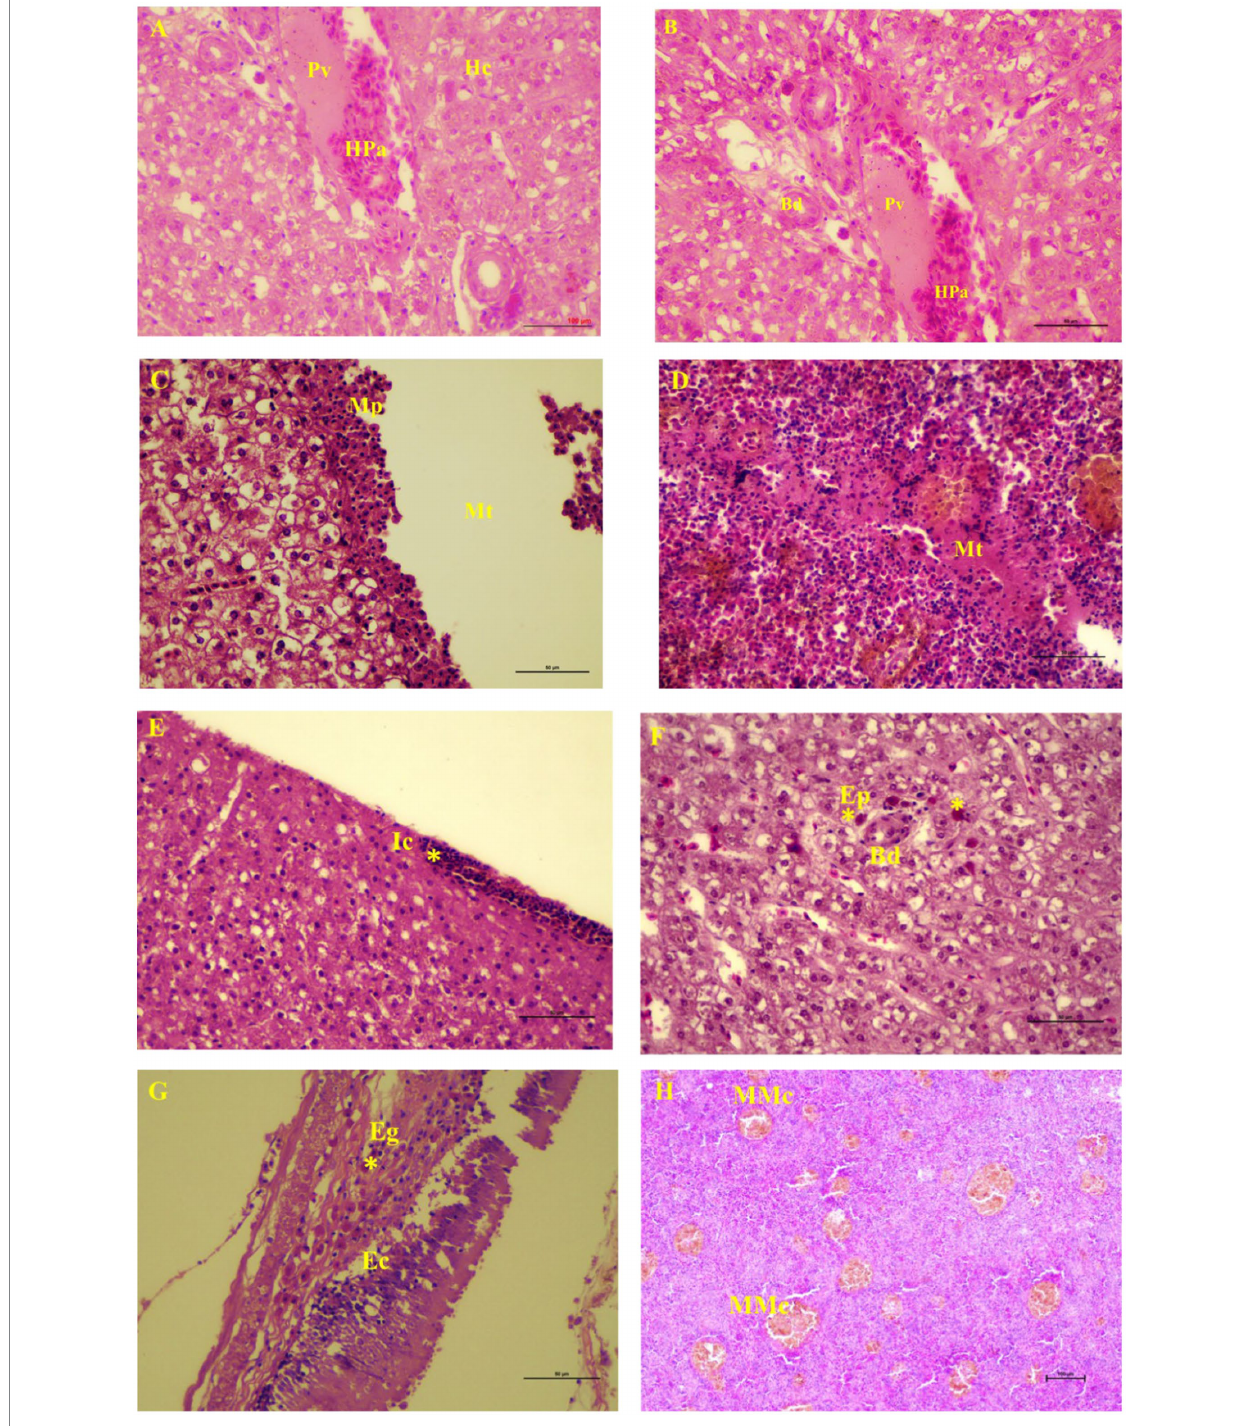
FIGURE 1 Light micrographs of visceral organs of Trichopodus pectoralis non-infected (A) and infected (D–H) with Clinostomum piscidium (H&E stained). (A) Liver of non-infected fish shows the normal arrangement of hepatocytes (Hc) into cords or plates. Hepatopancreas (Pa) lies around a portal vein (Pv). (B) Normal arrangement of bile duct (Bd) proliferation around the portal vein of the liver cell, (C) Liver of infected fish shows migratory track (Mt), macrophages (Mp) near the migratory track, (D) Spleen of infected fish shows migratory track where the red blood cells are absent and changes in the necrotic tissue, (E) Inflammatory cells (Ic) in the periphery (asterisk) of the liver cells, (F) Eosinophilic cells (asterisk) in the cytoplasm around the bile duct of the liver cell, (G) Eosinophilic granular cells (Eg; asterisk) near the epithelial cells (Ec) in the infected intestine, and (H) Many melano- macrophage cells (MMc) in the infected